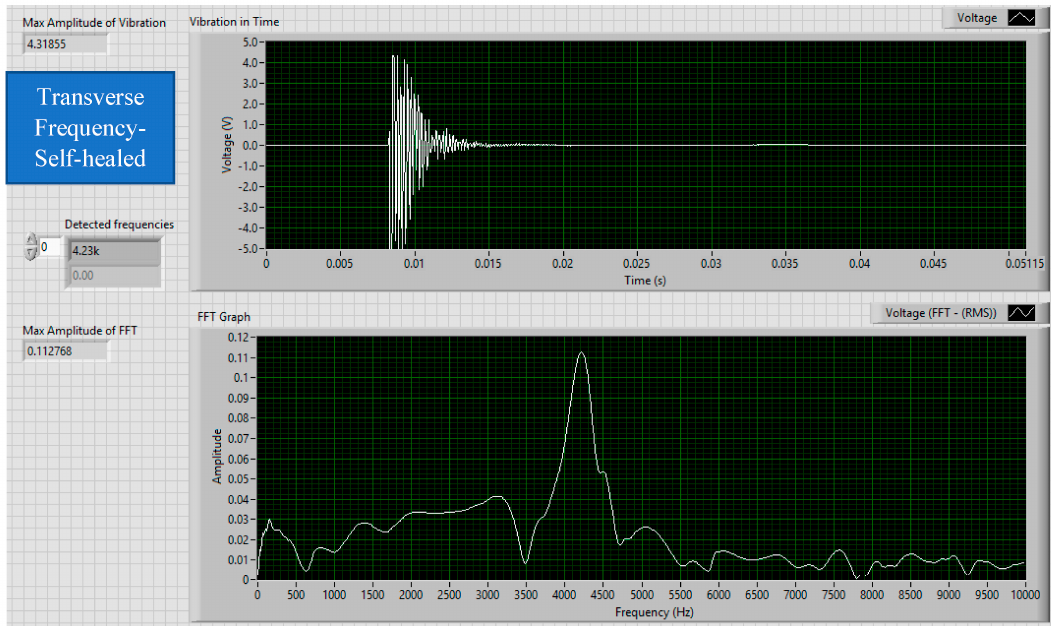
Figure 7. Transverse mode vibration and resonant frequency of cracked micro PFRC cylinder.